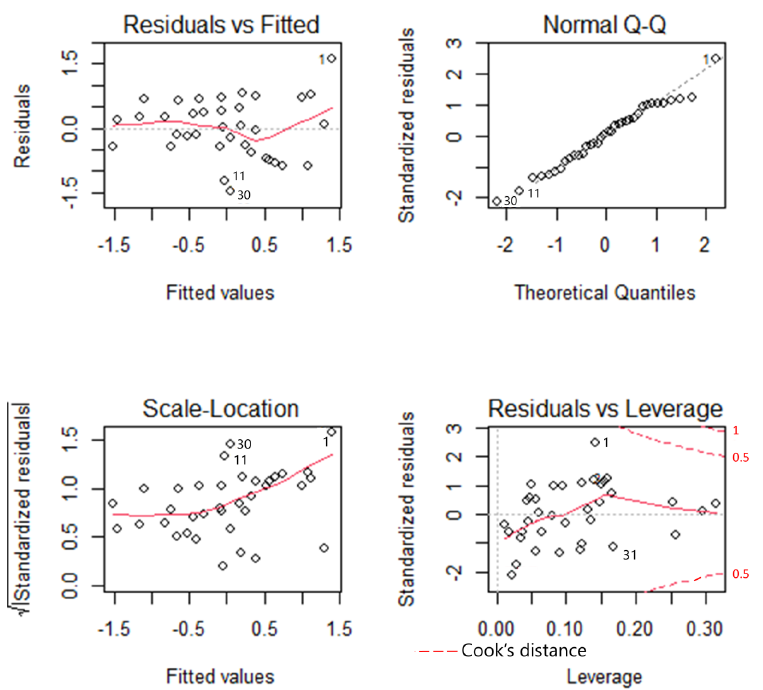
Figure A3. Model diagnostics for the best model with overall spring AA as the explained variable, and 15 climate variables and the Year as explanatory variables for the Blackcap Sylvia atricapilla (Table A12).